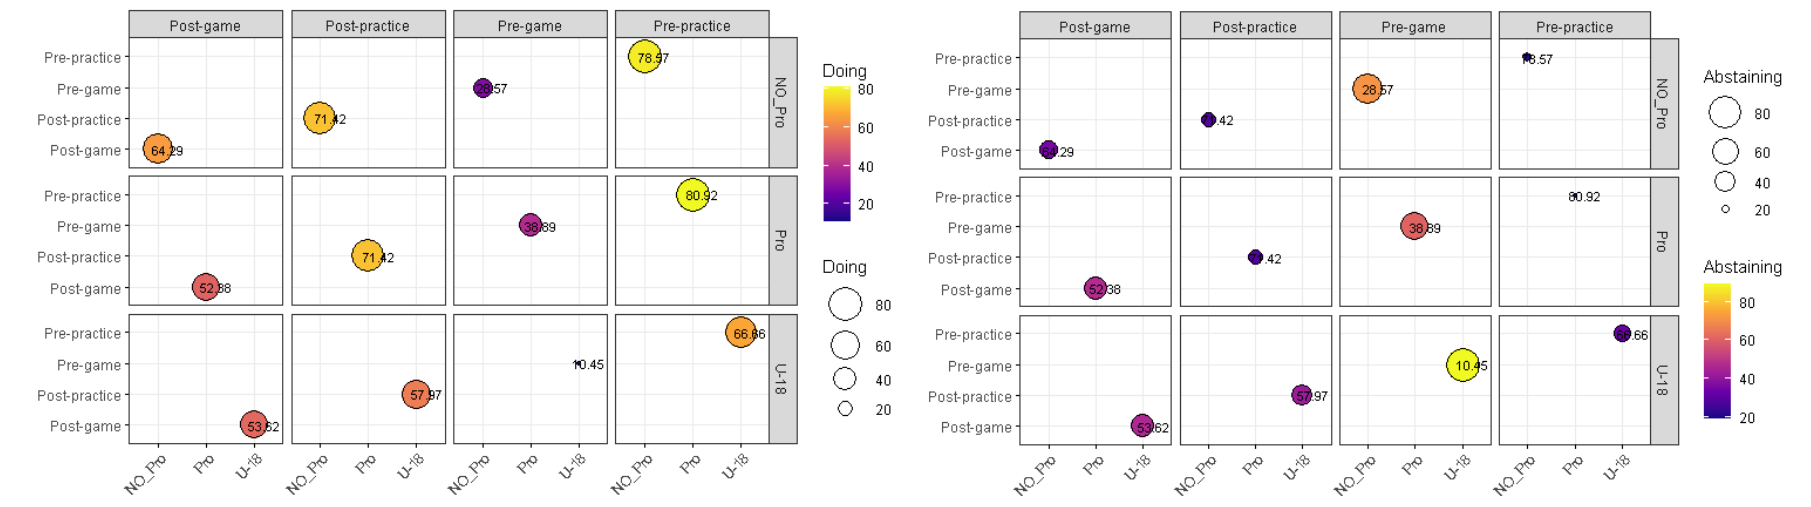
Figure 3. Sports nutrition practices. This figure compares the percentage of players following or not following the nutritional practices.